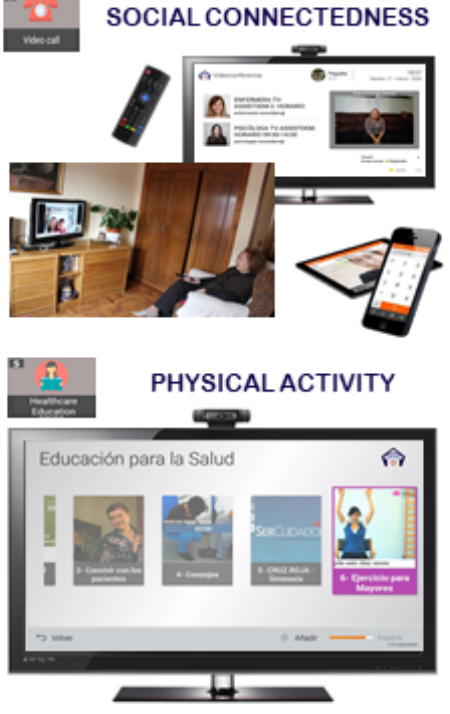
Figure 3. TV-AssistDem focused on social connectedness and physical